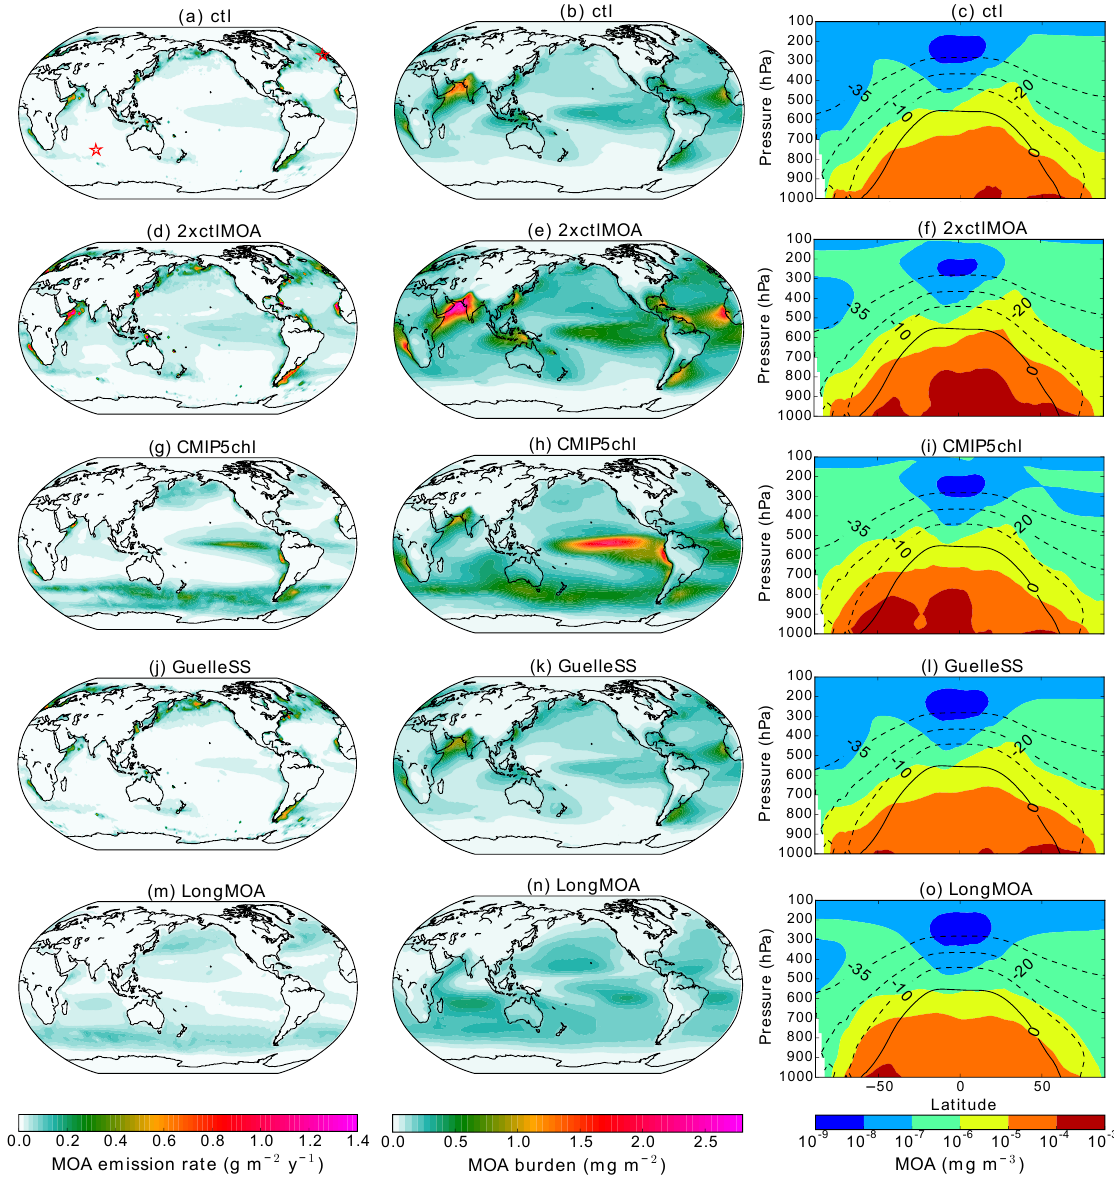
Figure 3. Multi-annual mean emissions (a, d, g, j, m) , burdens (b, e, h, k, n) , and zonal mean cross sections (c, f, i, l, o) of MOA from the various nudged simulations described in Table 2 for the period from March 2002 to May 2009. Contour lines in the zonal mean plots are zonal mean isotherms in ◦ C in the mixed-phase temperature range. Red stars in panel (a) indicate locations of Mace Head in the Northern Hemisphere and Amsterdam Island in the Southern Hemisphere, where long-term observations of MOA are